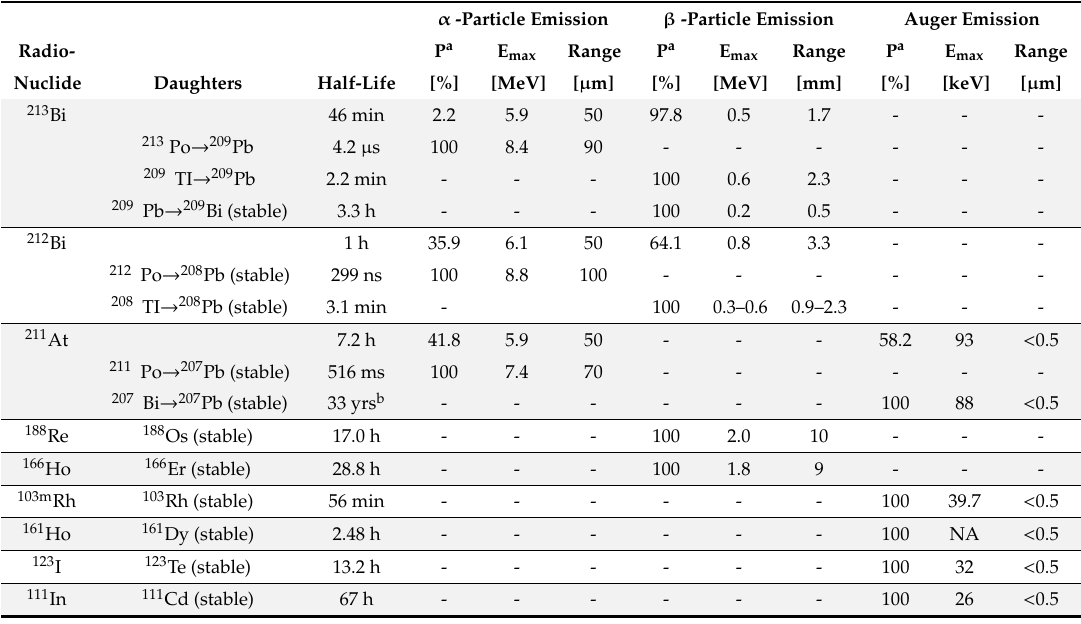
Table 5. Radionuclides with potential for anti-viral